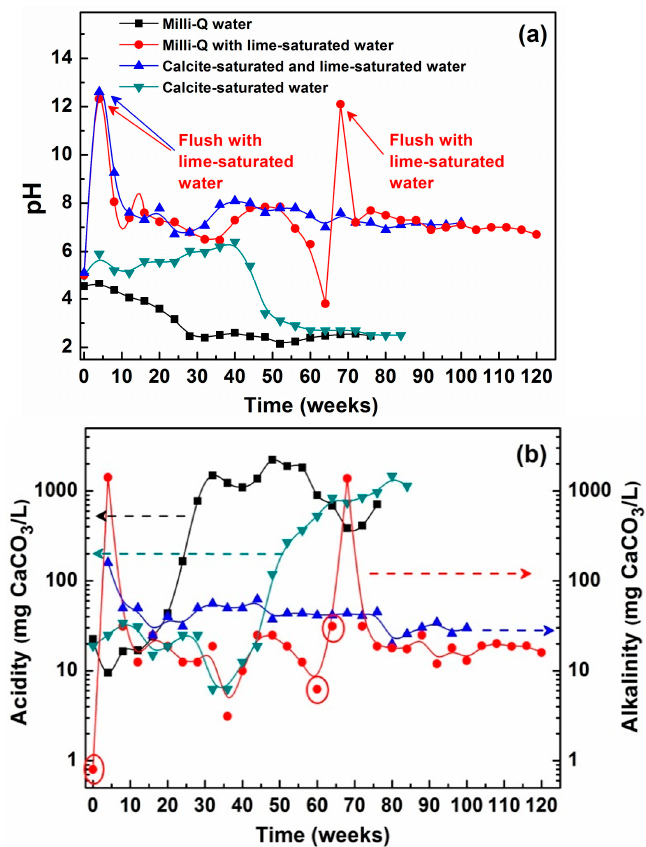
Figure 2. Characteristics of leachates from KLC tests using the synthetic waste: ( a ) pH; ( b ) acidity/alkalinity (both on log scales). The legends and line colours in (a) also apply to (b). Note that the three circled data points in (b) represent acidity, rather than alkalinity.